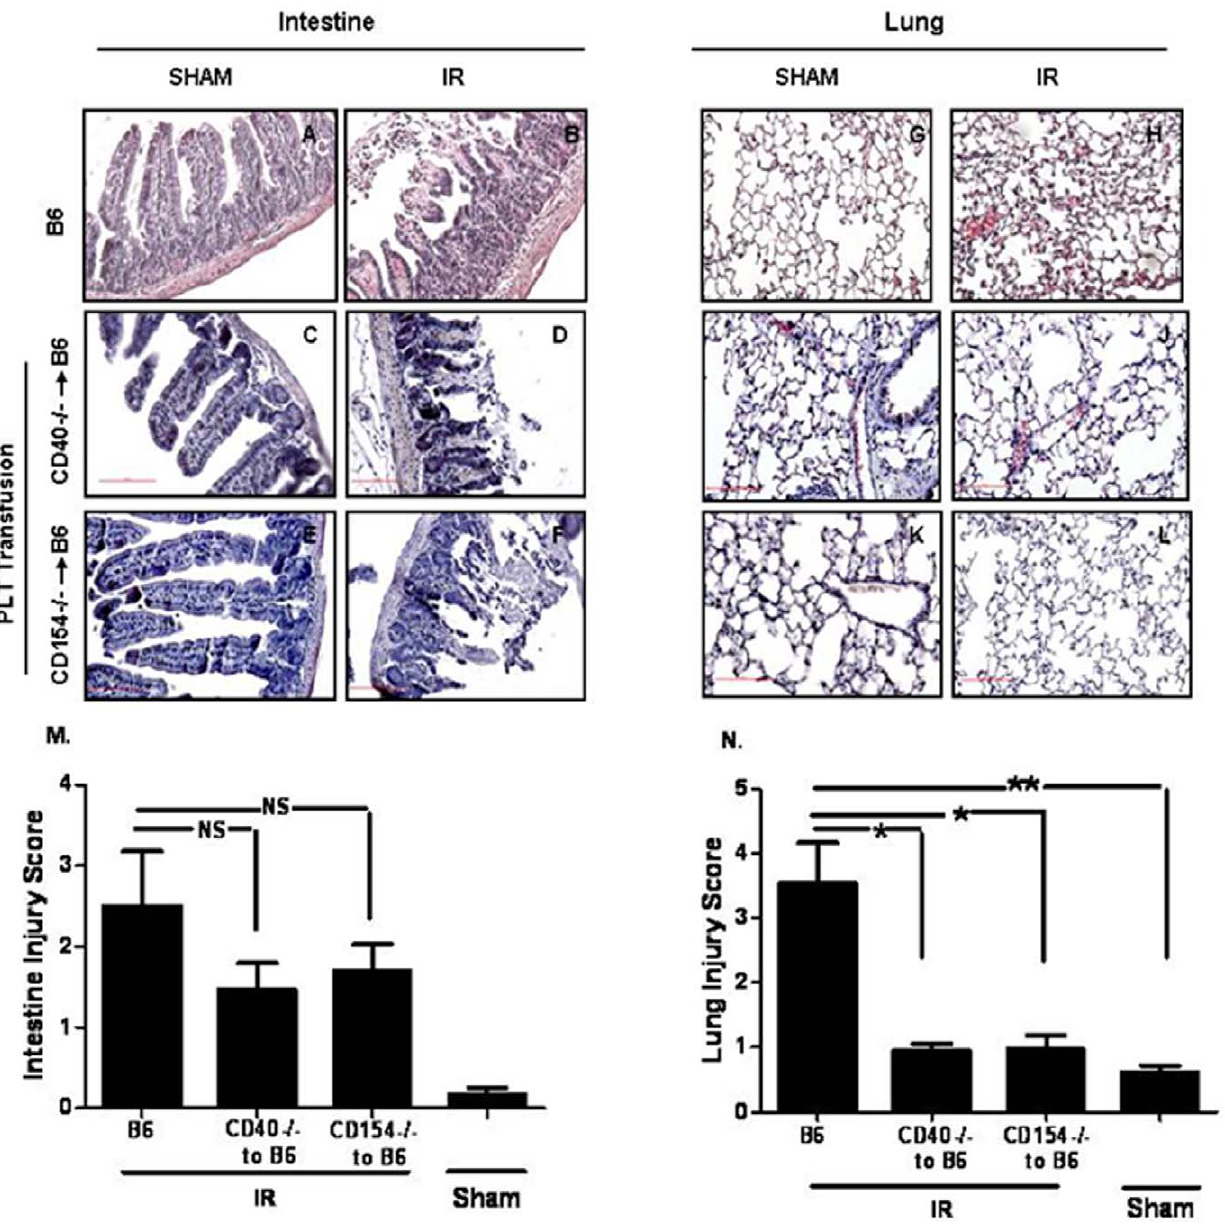
Figure 3. Transfusion of either CD40 2 / 2 and CD154 2 / 2 platelets protects platelet depleted B6 mice from remote lung injury but not from local intestinal injury. (A–L) Hematoxylin and eosin stained sections of mouse small intestine and lung from B6 and platelet depleted B6 mice transfused with either CD40 2 / 2 or CD154 2 / 2 platelets after 30 minutes of ischemia and 3 hours reperfusion. Images are representative of 3–4 mice per group in two experiments. All images shown are 200 6 magnification. (M)Intestinal injury score and (N) Lung injury score (mean 6 SD). ns: not significant *p # 0.05, **p # 0.01, and ***p # 0.001 for I/R compared to sham controls.